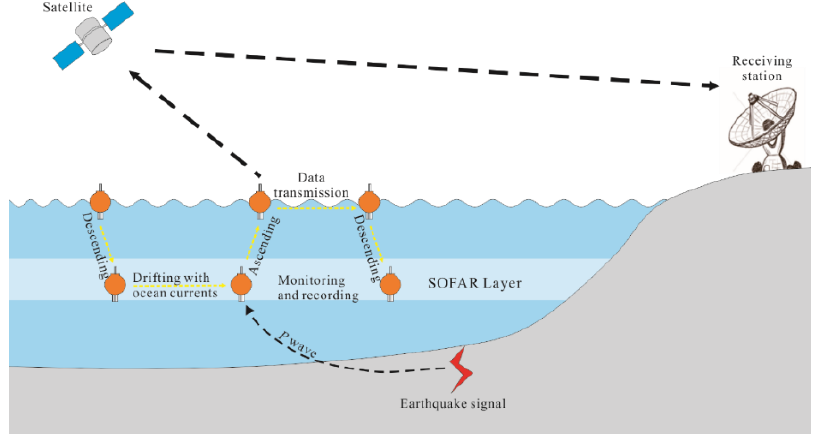
Figure 1. Working principle diagram of the floating ocean seismograph (FOS).